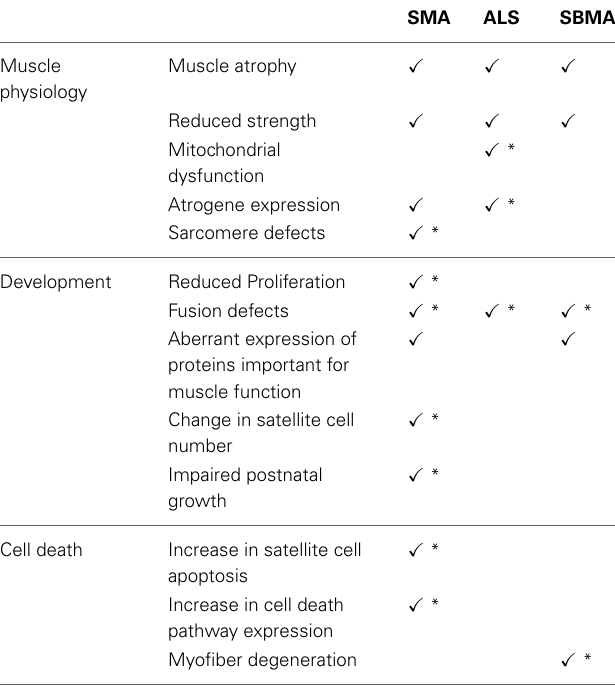
Table 2 | Summary of defects observed in muscle in motor neuron